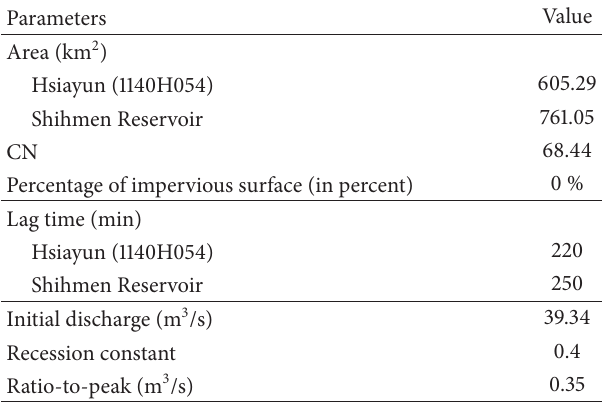
Table 2: Calibrated parameter values. The same parameters set was adopted in the HEC-HMS model, but the area and the lag time, due to the difference of area between the Hsiayun catchment and the Shihmen Reservoir catchment, were adjusted from 605.29 to 761.05 km 2 and from 220 to 250 min, respectively.